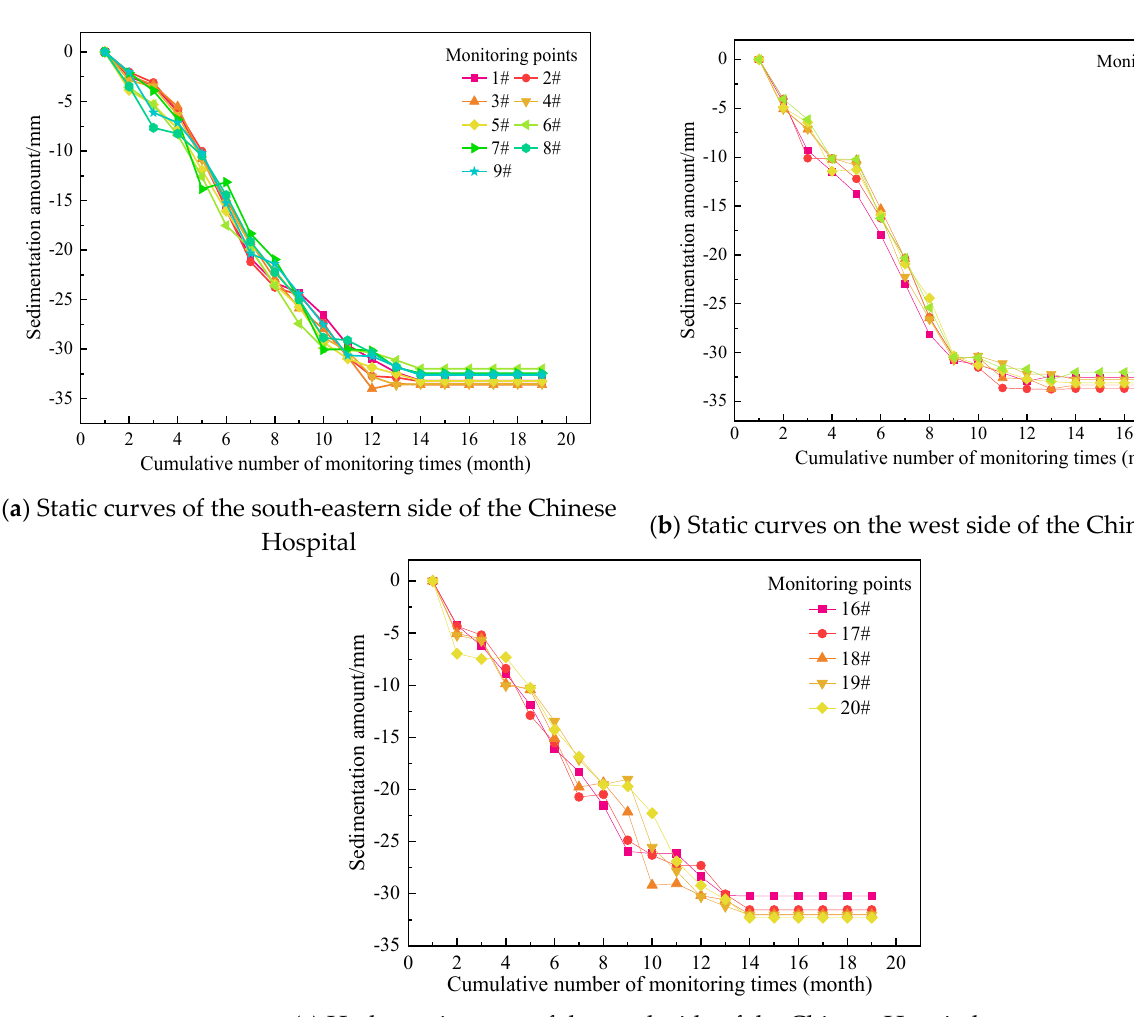
( c ) Hydrostatic curve of the north side of the Chinese Hospital Figure 19. Static graph. Figure 19. Static